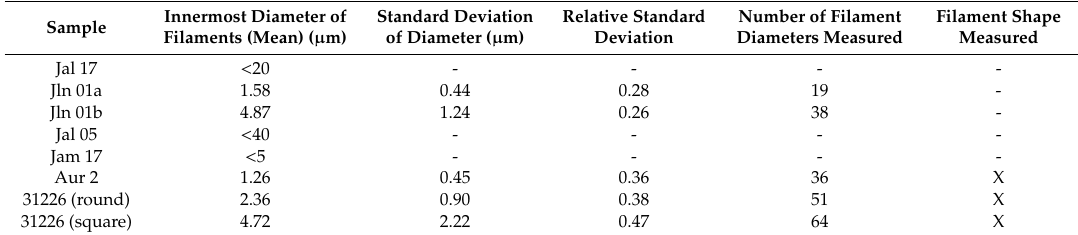
Table 2. Innermost diameters of filament structures in investigated MDP